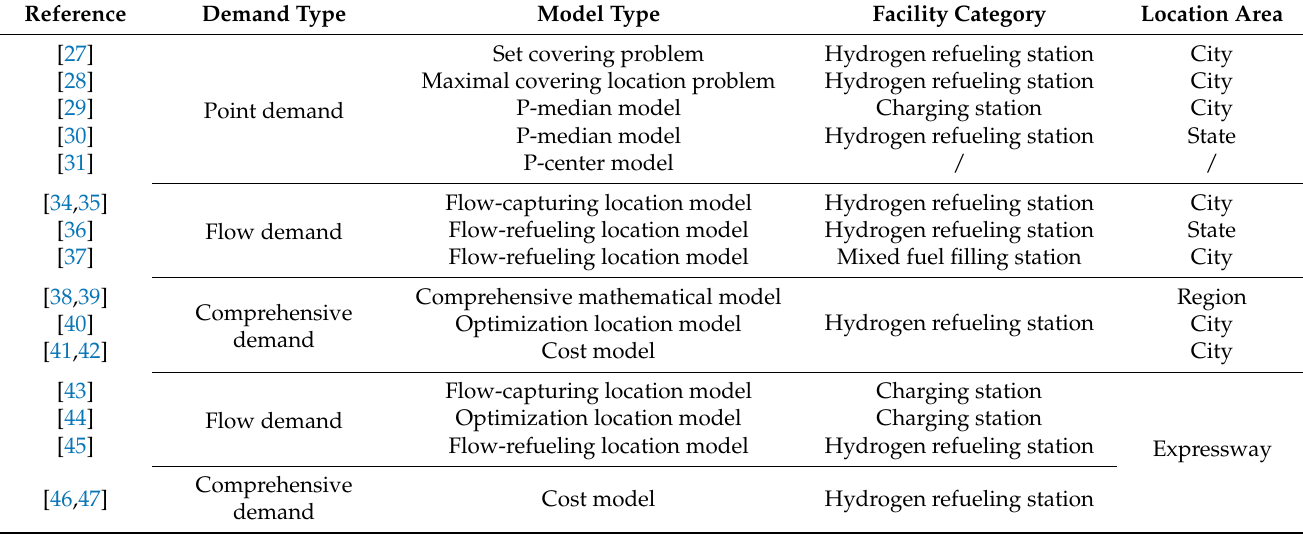
Table 1. The summary of existing research